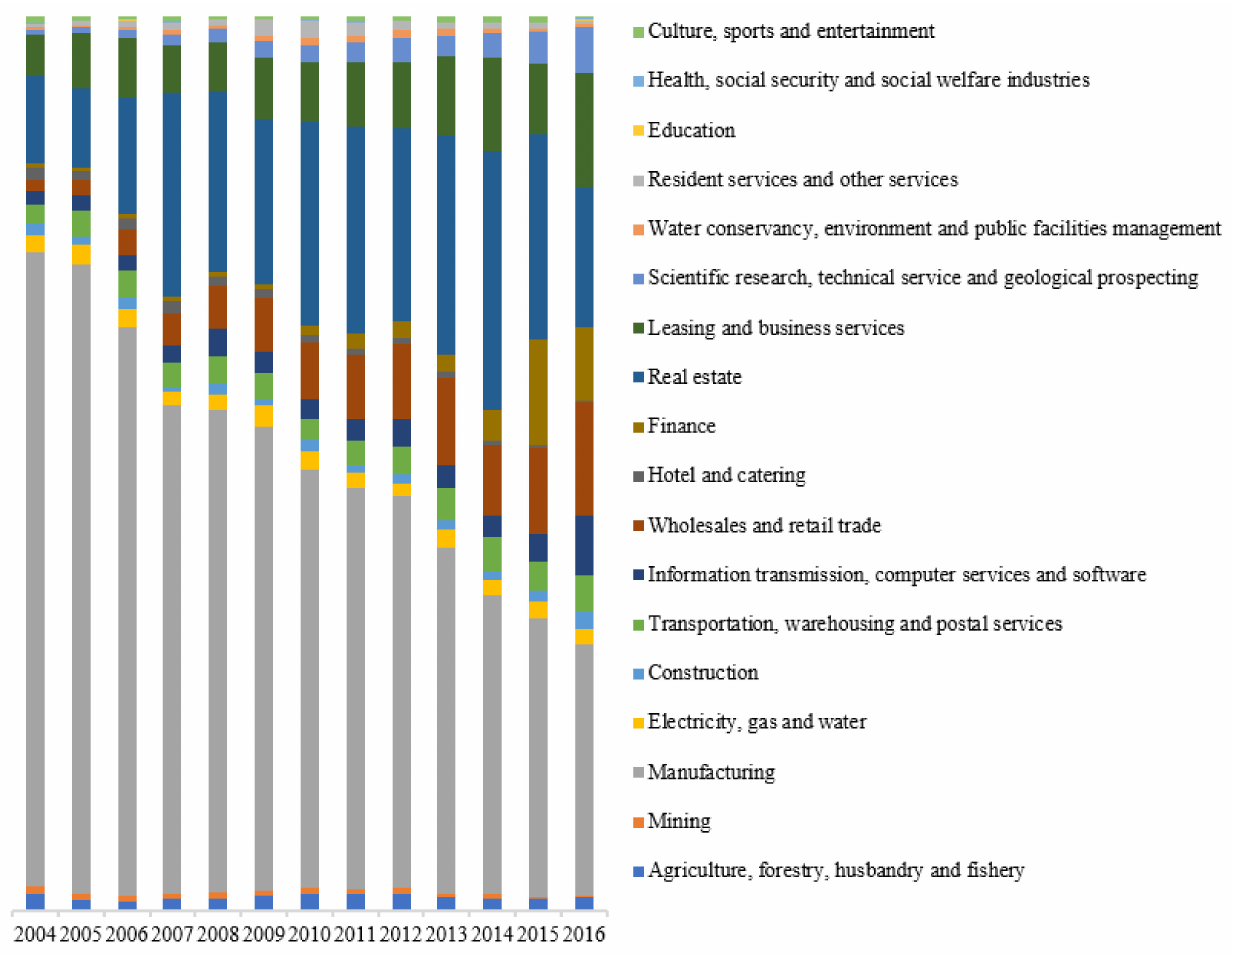
Figure 3. Industrial distribution of China’s FDI from 2004 to